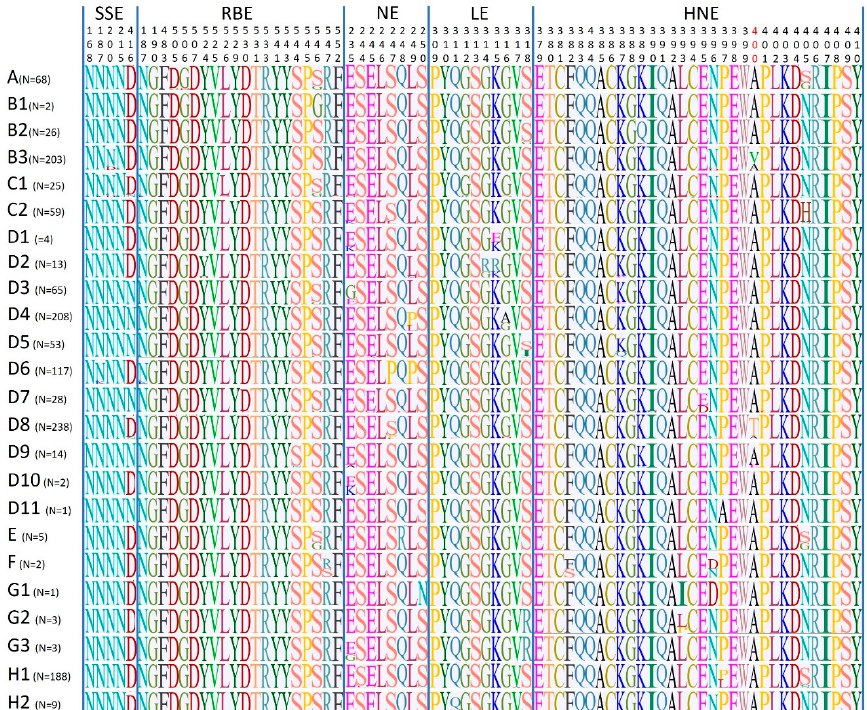
Figure 5. Sequence conservation at the level of the H immune epitopes. The figure shows alignments of the sequence logos obtained for each immune epitope and for each genotype. Immune epitopes (SSE: sugar-shielded epitope; RBE: receptor-binding epitope; NE: neutralizing epitope; LE: loop epitope; HNE: hemagglutinating and noose epitope) as well as amino acid positions are indicated at the top, while genotypes with the relative number of available H sequences are indicated on the left.